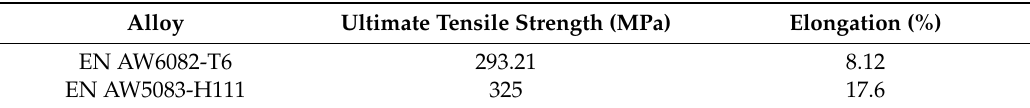
Table 2. Mechanical properties of aluminum alloys.